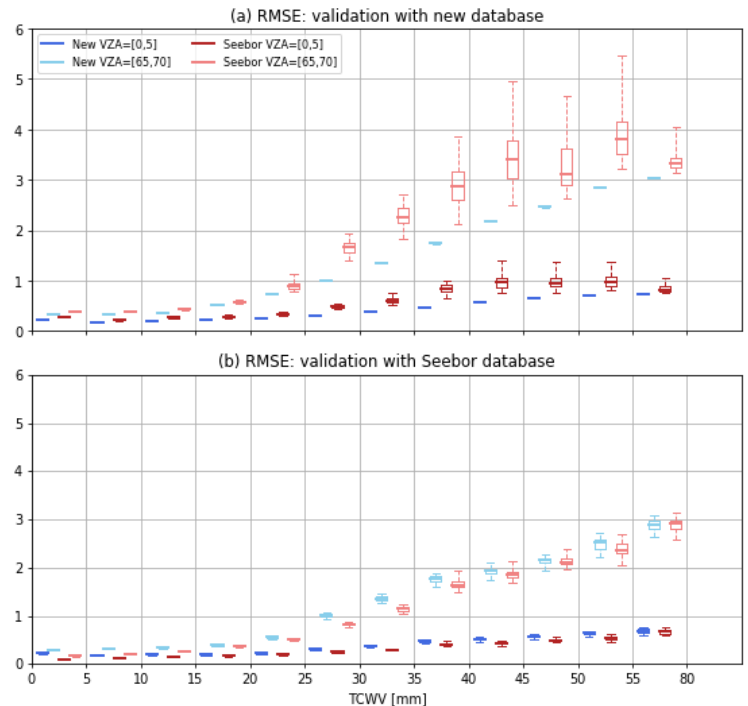
Figure 12. Distribution of Root Mean Squared Errors (RMSE) as obtained from 50 GSW model fits using the new database (blue colors) and the SeeBor database (red colors) for training and using the new database ( a ) and the SeeBor database ( b ) for validation. Distributions are shown for each TCWV class ( x -axis) and for VZA classes of 0° to 5° (darker colors) and 65° to 70° (lighter colors). The bold line represents the median, the box represents the 25th to 75th percentiles, and the whiskers represent the 5th and 95th percentiles.